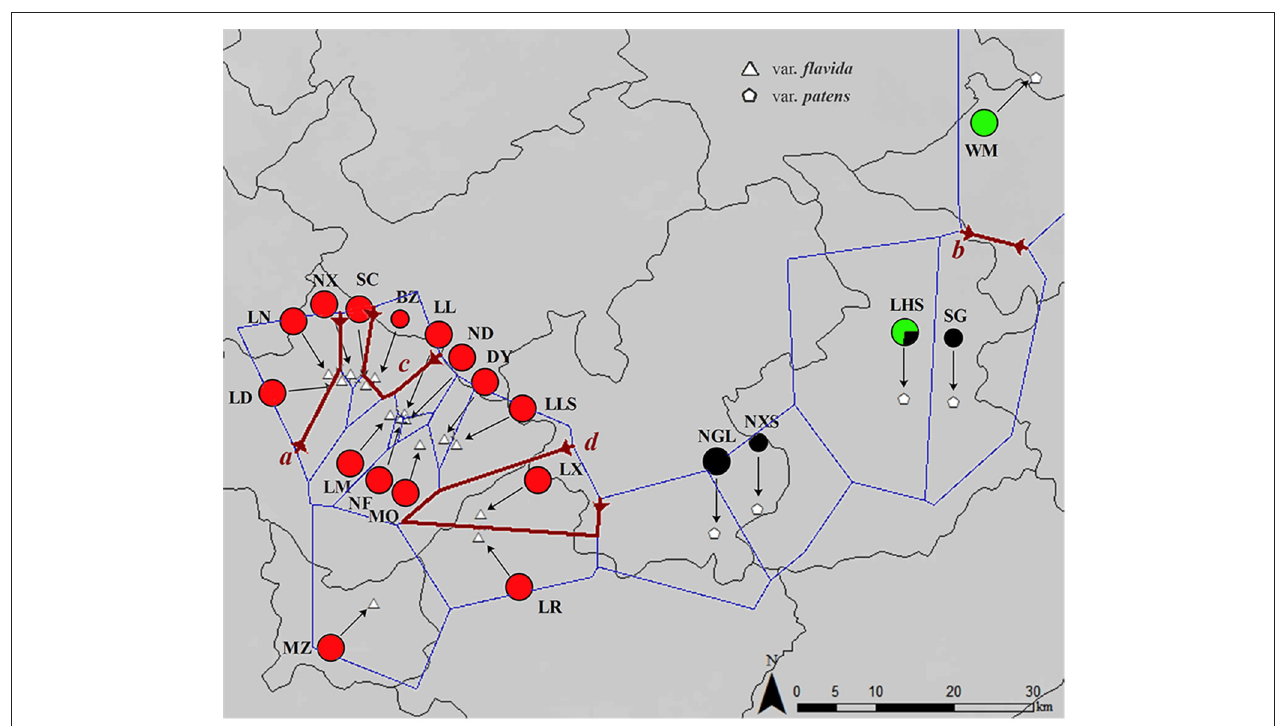
FIGURE 1 | Map of the sampling location and results of the barrier analyses. The colors of the populations represent the cpDNA haplotype lineages as identified by phylogenetic analyses. The first four barriers a , b , c , and d defined by the Monmonier algorithm of the PAL datasets are represented by dark red lines.